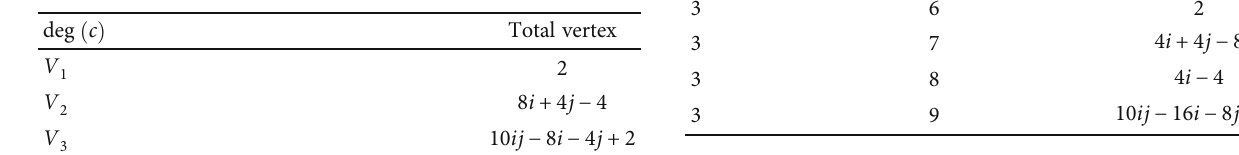
Table 7: Ve-degree of end vertices of each edges of SiC - II ½ i , j (cid:2) . 4